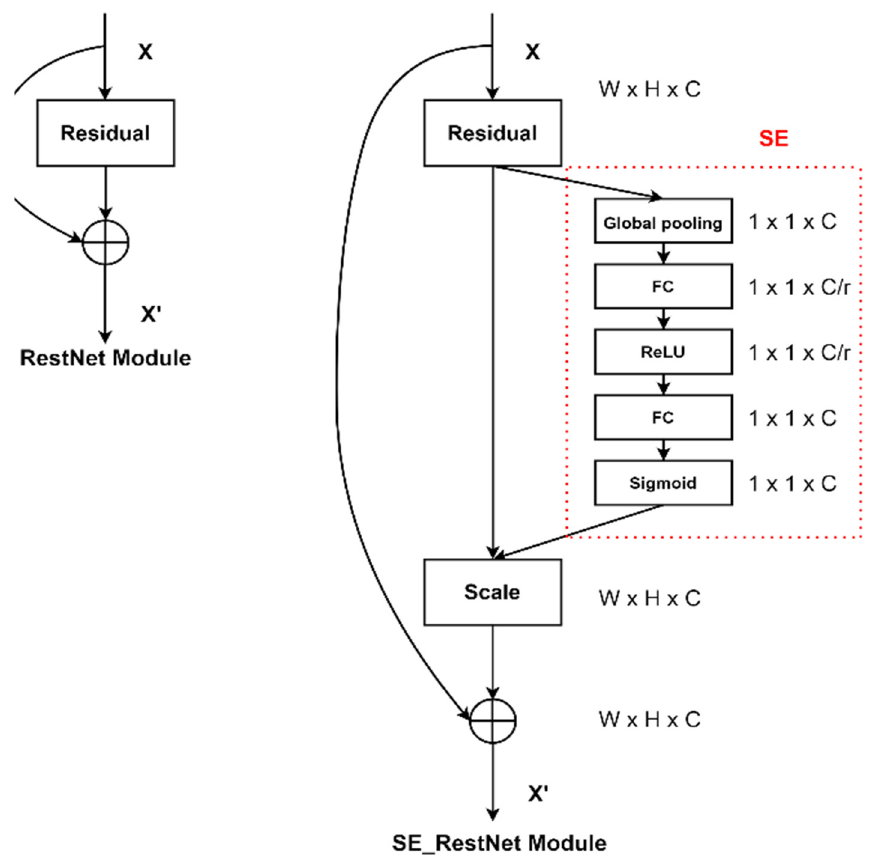
Figure 14. SE attention mechanism optimizes GhostNet_SEResNet56 network.